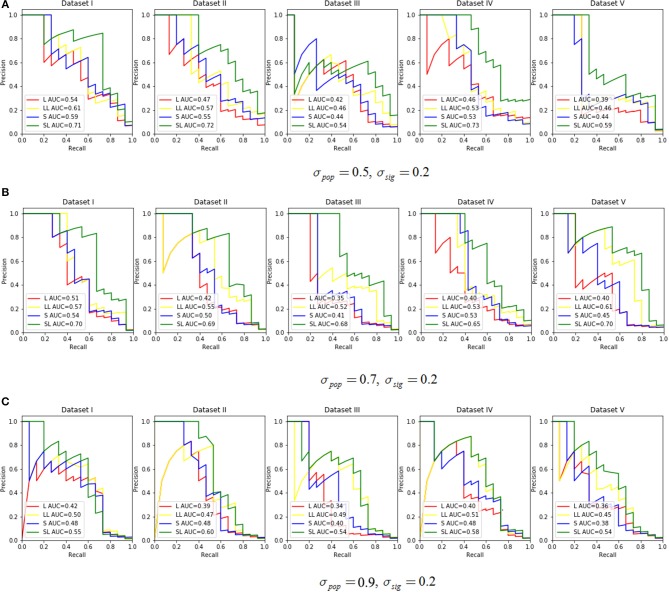
The Precision Recall curve by varying the σpop ∈ {0.5, 0.7, 0.9} and set σsig = 0.2. Each parameter combination had five datasets. The legend in each subplot shows the area under the curve (AUC) for each method. L represents Lasso only, LL means Lasso-LMM, S is SGL only, and SL means SGL-LMM. (A) Shows the PR curve under σpop = 0.5, σsig = 0.2, (B) for σpop = 0.7,σsig = 0.2, and (C) for σpop = 0.9,σsig = 0.2.